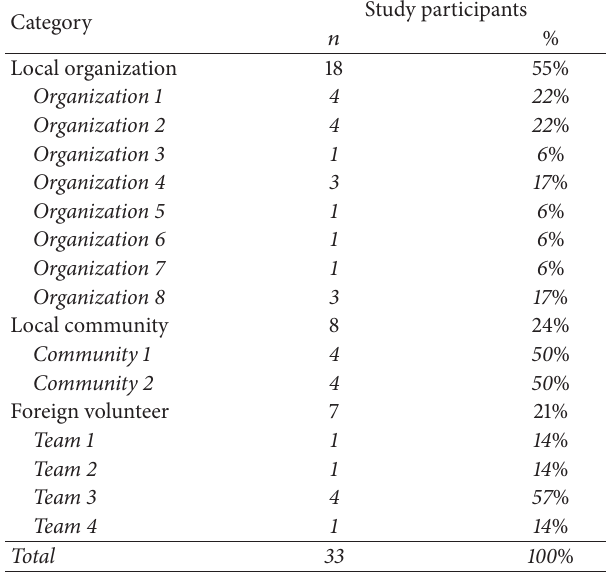
Table 1: Study participants’